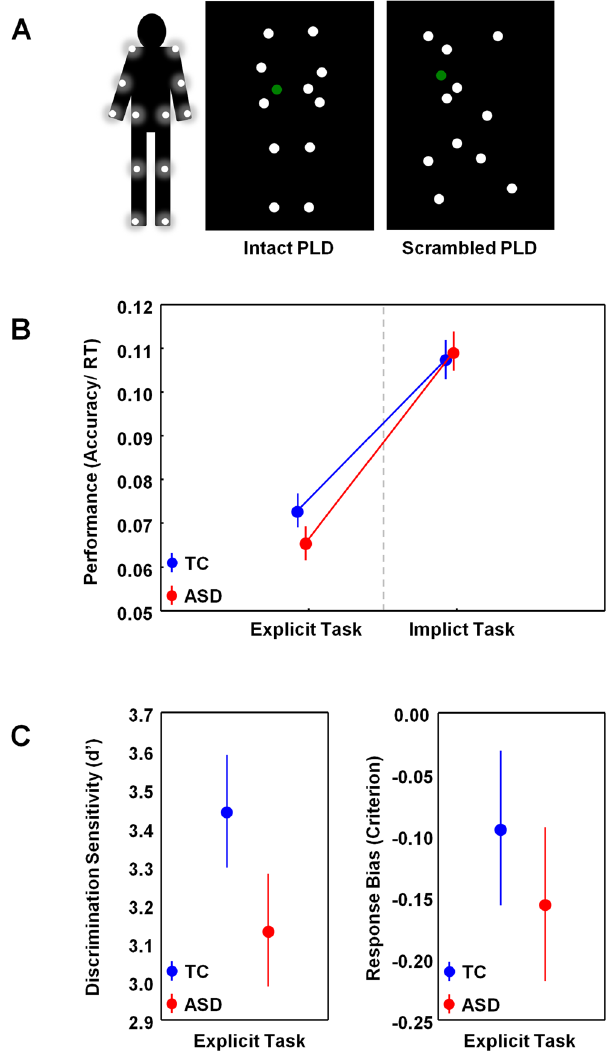
Figure 1. Experimental task. Panel A visualizes an example of an intact and scrambled point light display (PLD) stimulus. In the explicit task condition, participants were instructed to indicate as fast and accurate as possible whether the presented PLD represented ‘a person’ or ‘not a person’. In the implicit task condition, participants were instructed to indicate color changes in the moving dots (at a random time point, one dot briefly changed color to either ‘red’ or ‘green’). Panel B visualizes performance scores (accuracy/reaction time) for the explicit and implicit task condition, separately for each group (TC, ASD). Panel C visualizes discrimination sensitivity (d’) and response bias scores (criterion) for the explicit task condition, separately for each group (TC, ASD). Vertical bars denote + / − standard